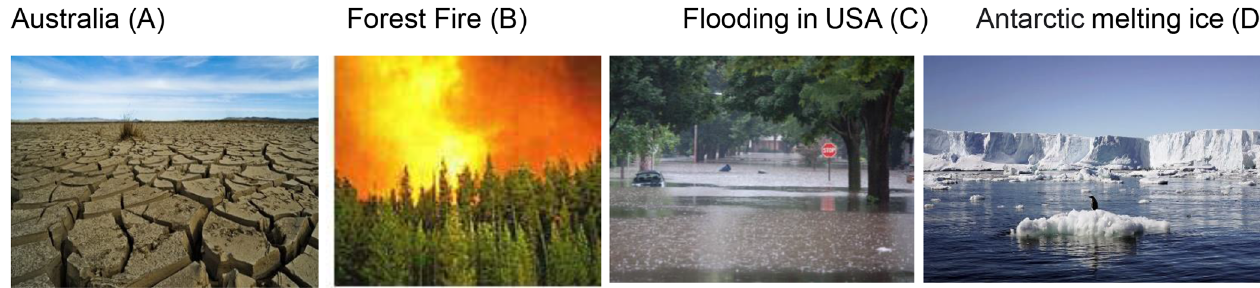
Fig. 1. Effects of climate change.